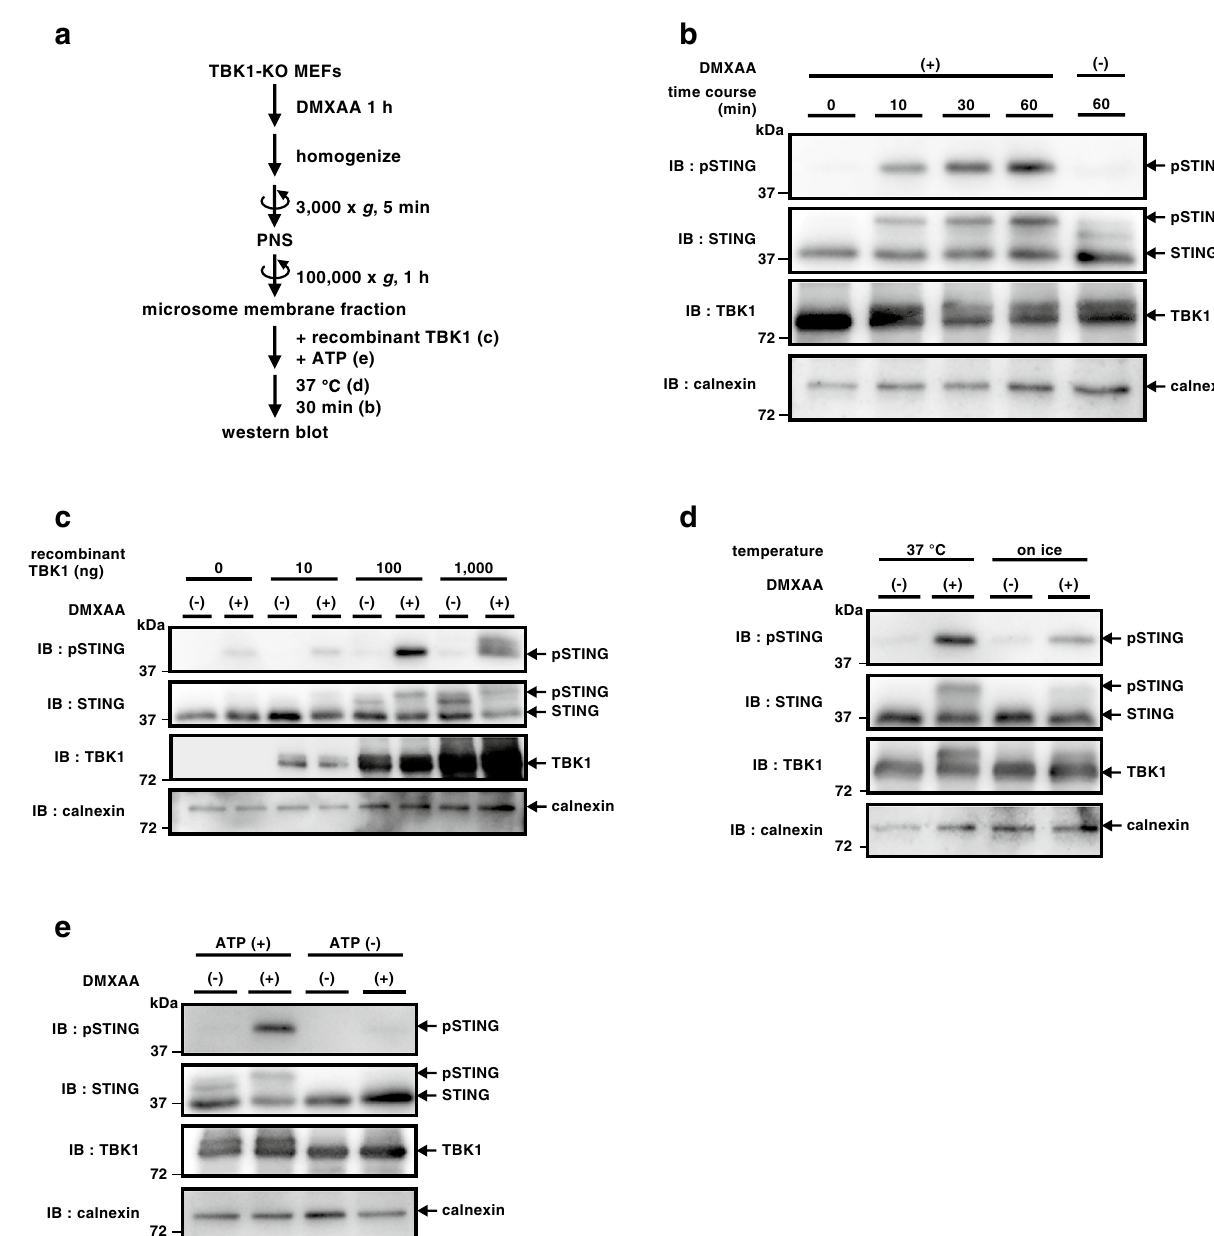
Figure 2. TBK1-dependent phosphorylation of STING in vitro. ( a ) A protocol for TBK1-dependent phosphorylation of STING in vitro. ( b–e ) TBK1-knockout MEFs were stimulated with DMXAA (25 µg/mL) for 0 or 1 h, homogenized in isotonic buffer, and centrifuged at 3,000 × g for 5 min. The resulting post-nuclear supernatants were then centrifuged at 100,000 × g for 1 h, and the pellets were resuspended in isotonic buffer. The resuspended membrane fractions were incubated with recombinant TBK1 (100 ng) and ATP (1 mM) at 37 °C for 0, 10, 30, or 60 min ( b ). The membrane fractions were incubated with ATP and the indicated amount of recombinant TBK1 (0 ng, 10 ng, 100 ng or 1,000 ng) at 37 °C for 30 min ( c ). The membrane fractions were incubated with ATP and recombinant TBK1 at 37 °C or on ice for 30 min ( d ). The membrane fractions were incubated with recombinant TBK1 in the presence or absence of ATP at 37 °C for 30 min ( e ). Phosphorylation of STING at Ser365 was then analyzed by western blot ( b – e